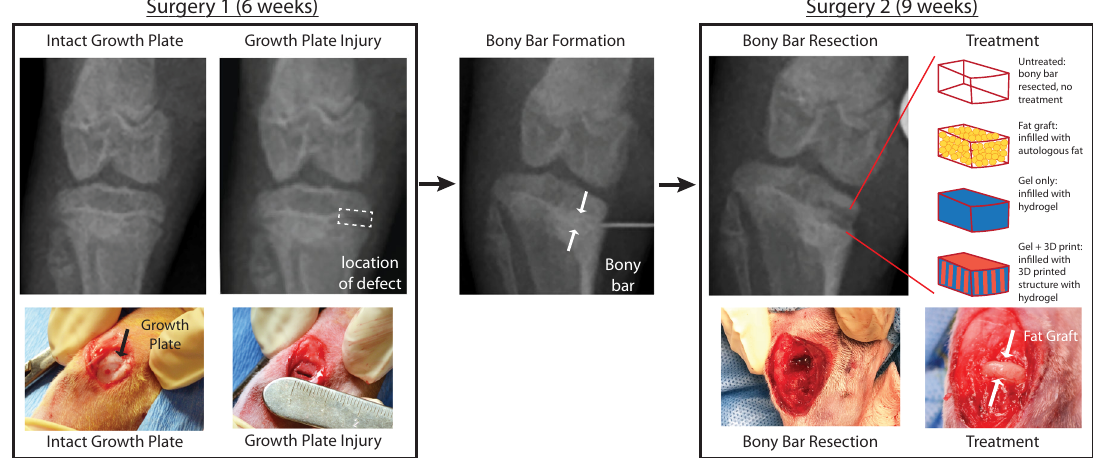
Fig. 6 Overview of rabbit growth plate injury model using a two-surgery approach. The fi rst surgery to create an initial growth plate injury occurs at 6 weeks of age, where a 1 mm drill bit attached to a Dremel is used to make a 5 × 5 × 1 mm defect. A bony bar forms in the injured area during the 3 weeks after surgery. The second surgery when the rabbit is 9 weeks of age uses a 2 mm drill bit to remove the bony bar and reopen the defect in a 6 × 6 × 2 mm region. After bony bar resection, one of four treatment options are applied: untreated, fat graft, gel only, gel + 3D